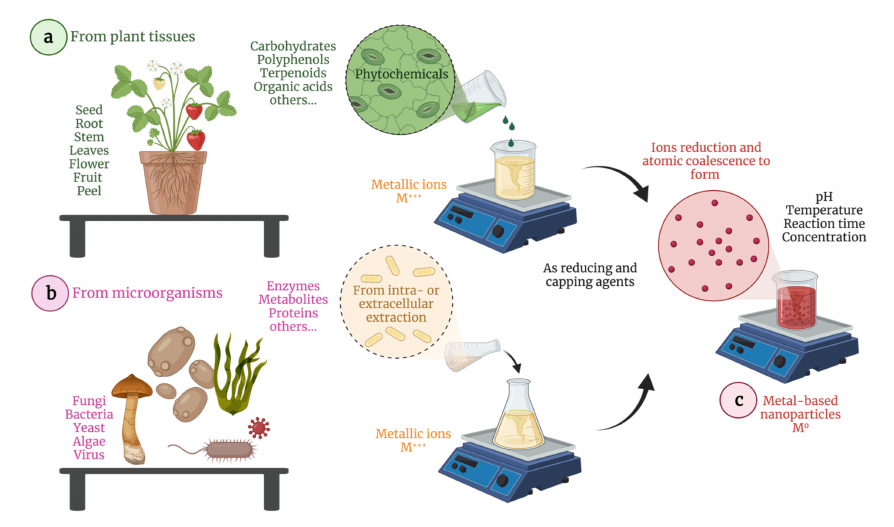
Figure 1. Schematic representation of the biosynthesis of MNPs ( c ) mediated by plants tissues ( a ) and microorganism derivatives ( b ). Illustration created with BioRender.com (accessed on 22 August